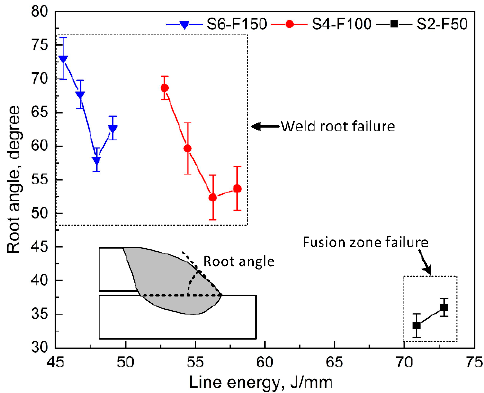
Figure 13. Distribution of weld root angle as function of welding parameters.